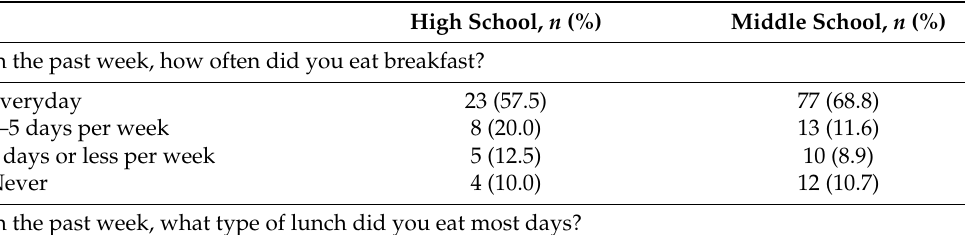
Table 4. Dietary habits of active high school and middle school